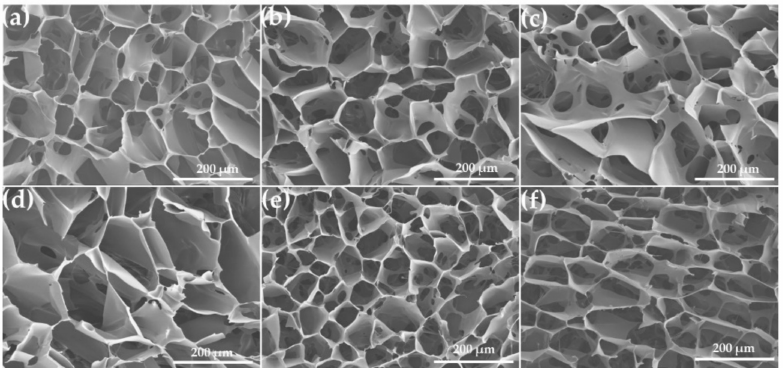
Figure 3. Scanning electron microscopy (SEM) images of the cross-section for porous PHMB / SF sponges. PHMB / SF ratios: ( a ) 0 / 100; ( b ) 0.5 / 100; ( c ) 1 / 100; ( d ) 2 / 100; ( e ) 5 / 100; ( f ) 10 /